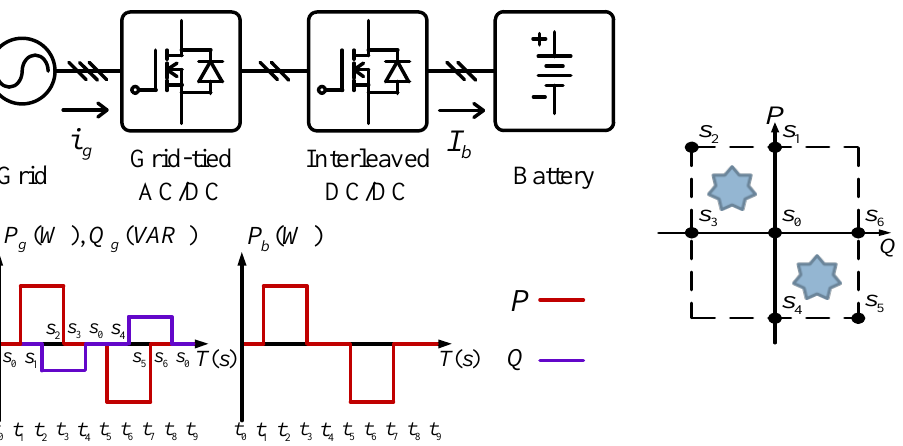
Figure 23. PCS operating in the 2nd and 4th quadrants.